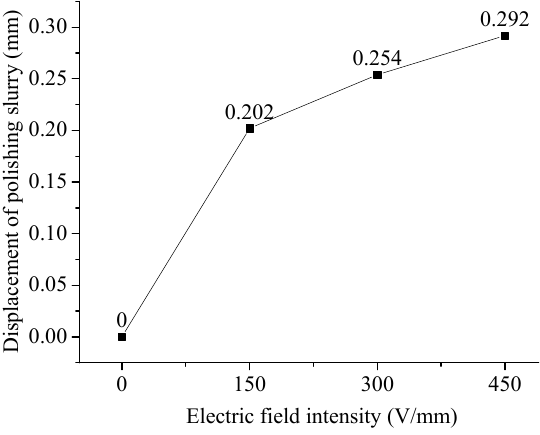
Figure 9. The displacement of the polishing slurry at 40 Hz: ( a ) initial state and ( b ) 40 Hz.